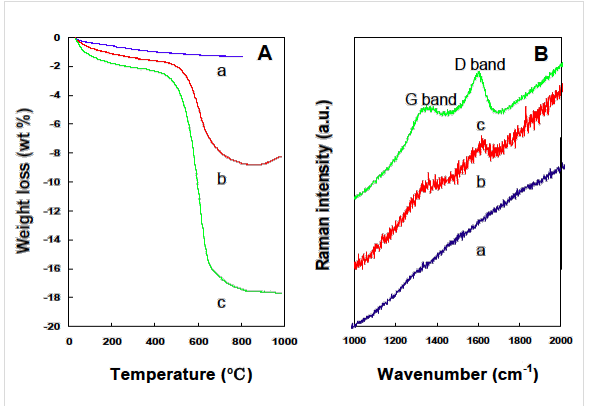
photoactive sites, and the other one is the existence of trace carbon in the silica nanotubes (less than 0.9 wt % estimated by